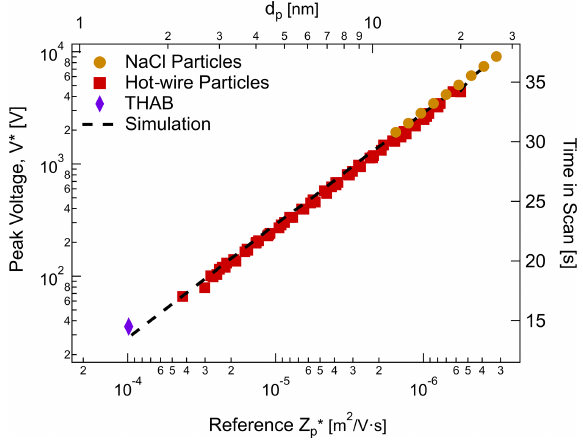
Figure 11. Particle size distribution measured by the nSEMS during a nucleation and growth event in the CLOUD 13 cam- paign with anthropogenic trace gases. The experiment was con- ducted at − 10 ◦ C and 60% RH, with 24pptv HNO 3 , 2131pptv NH 3 , 0.46pptv H 2 SO 4 , and 0.28pptv highly oxygenated or- ganic molecules (HOMs). The nSEMS high-voltage polarity was switched between scans to probe both positively and negatively charged particles from the soft x-ray CC. A clear bimodal size distribution was observed by the nSEMS due to the rapid co- condensation of nitric acid and ammonia (Wang et al., 2020). The activation diameter, d act , for nitric acid condensation is around